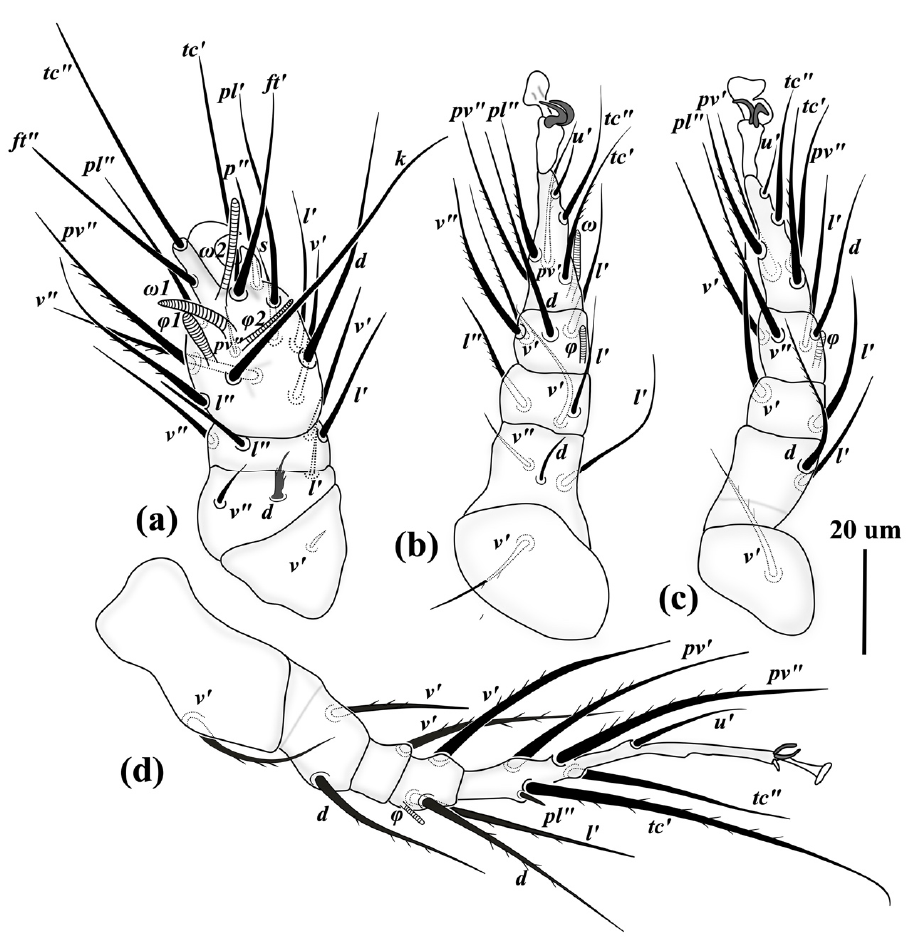
Figure 7. Right legs of Archidispus hydrophilus sp. nov . ( a ) leg I; ( b ) leg II; ( c ) leg III; ( d ) leg